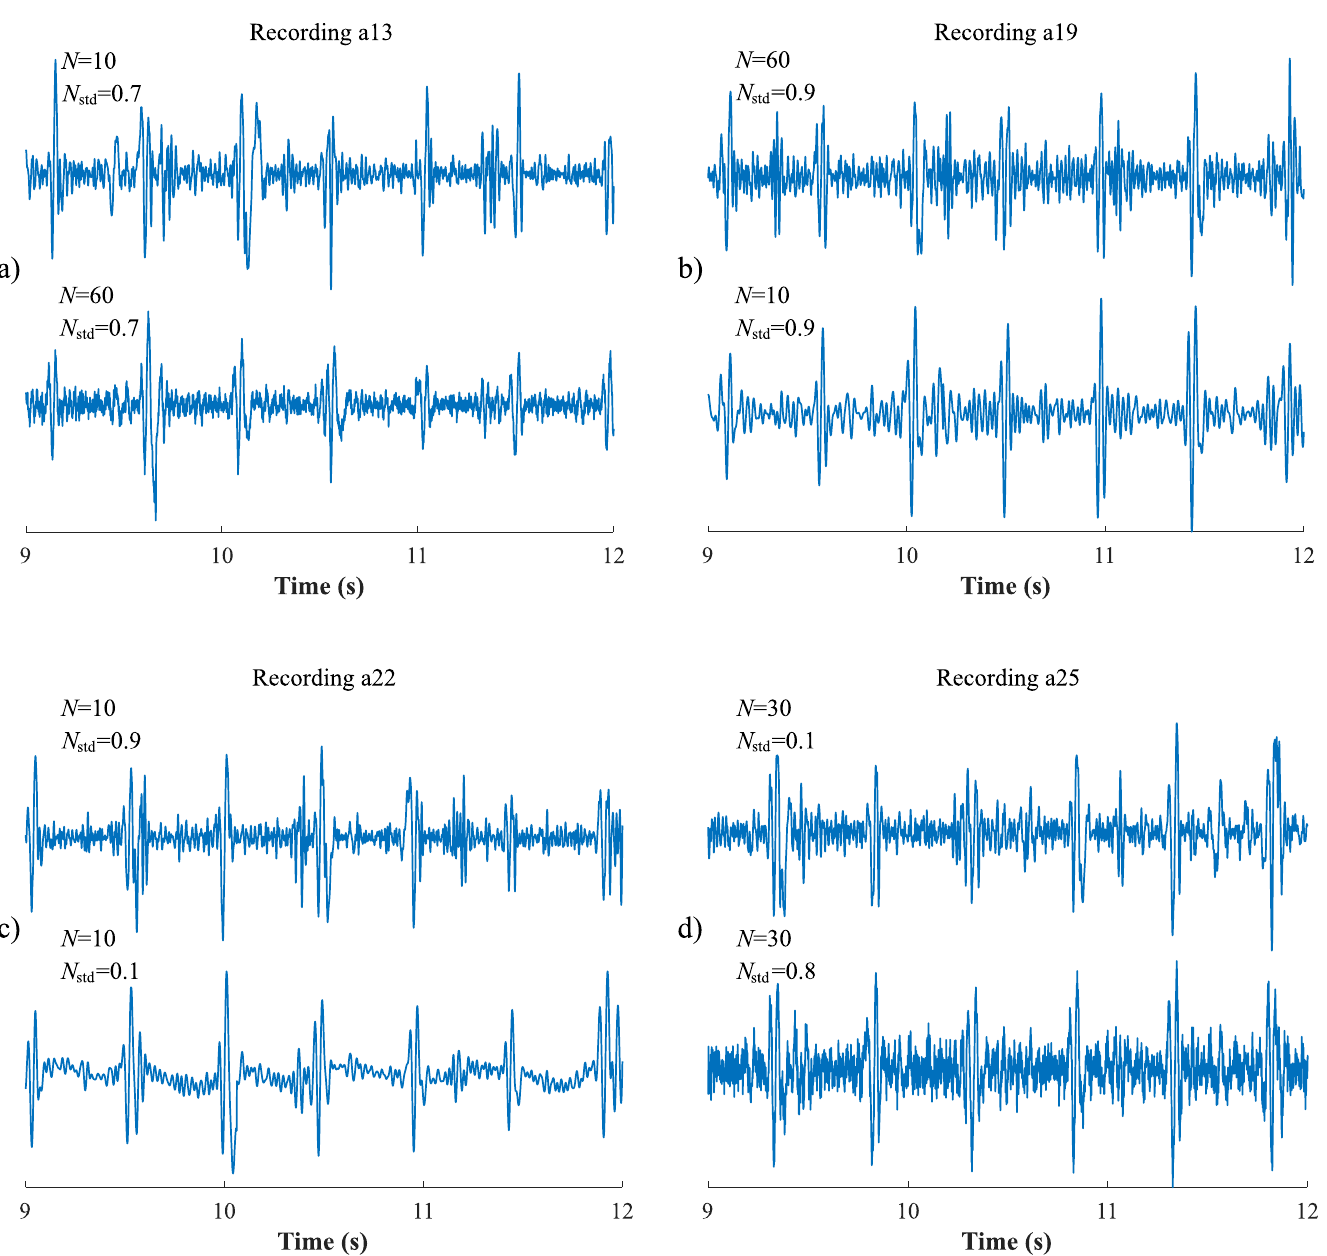
Fig 19. The influence of the EEMD parameters ( N and N std ) on the resulting quality of the fECG signal extraction. Examples a) and b) present the influence of the parameter N , while keeping a constant value of N . Examples c) and d) present the influence of the parameter N std